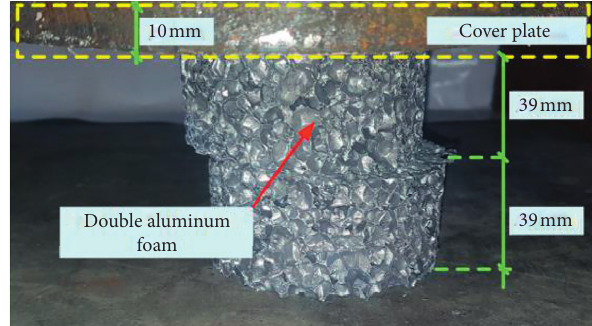
Figure 4: Sandwich plate antiexplosion test device.